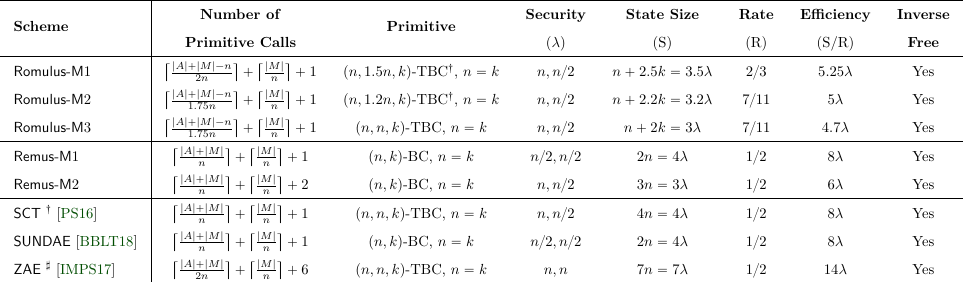
Table 2: Efficiency comparison of misuse-resistant AE schemes. λ is the bit security level of a mode. Here, p n, k q -BC is a block cipher of n -bit block and k -bit key, p n, t, k q -TBC is a TBC of n -bit block and k -bit key and t -bit tweak. x, y in the security column